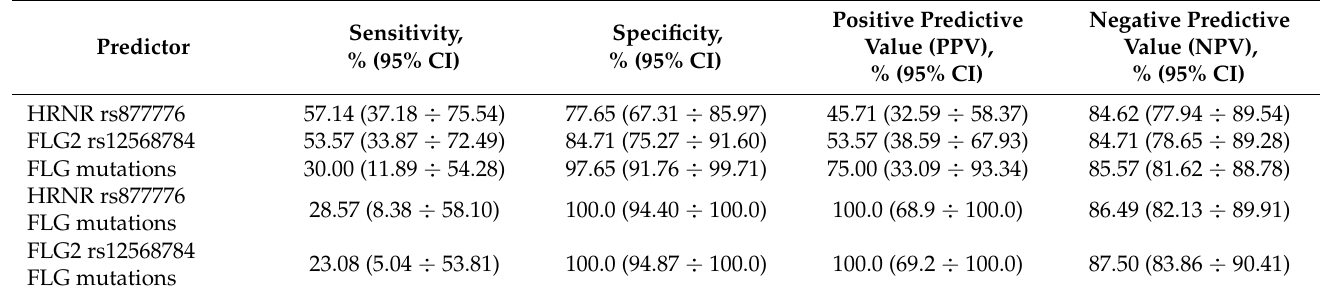
Table 7. The predictive values of risk factors (HRNR rs877776, FLG2 rs12568784, FLG mutations) for the eczema-associated asthma